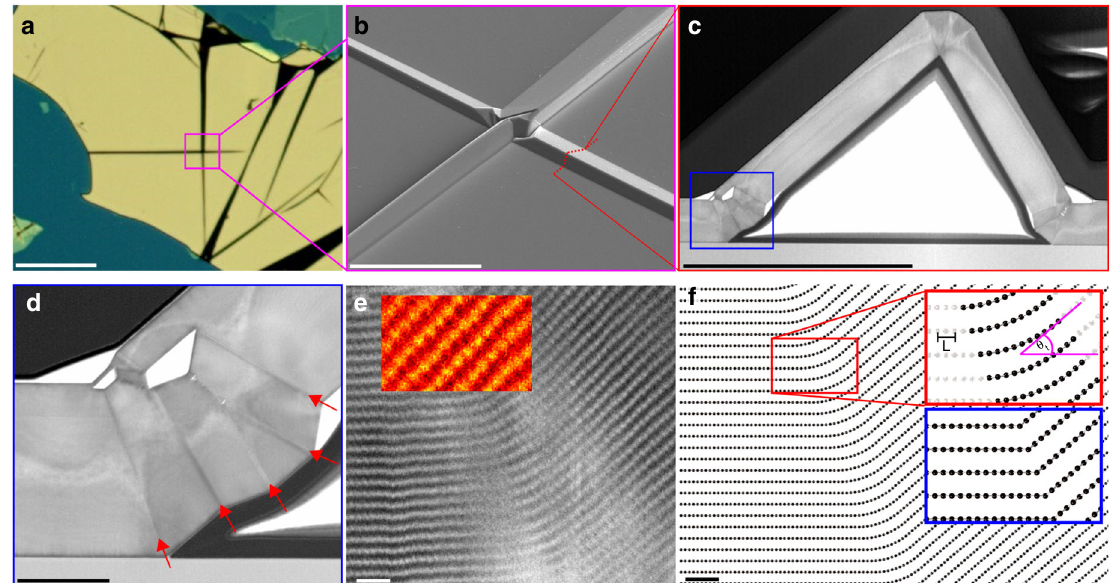
Fig. 1 Atomic structure of twin boundaries in layered vdW crystals, a Optical plan view image of a 200 nm thick graphite fl ake on silicon wafer. Stress induced kink bands can be seen intersecting one another at angular multiples of 30° (corresponding to zig-zag, zz, or armchair, ac, crystal directions). Scale bar 100 μ m. b Scanning electron microscopy (SEM) oblique view of zz kink band meeting an ac kink band at 90°. The site of the FIB cross-section is annotated red. Scale bar 10 μ m. c , d Bright fi eld STEM cross-sectional imaging of the ac kink band. The kink is composed of fl at areas of Bernal stacking bordered by many discrete boundaries of almost exactly the same angle, (boundaries annotated with red arrows) which are identi fi ed as incommensurate twin boundaries (see SI). Scale bars 1 μ m and 100 nm, respectively. e Filtered atomic resolution image of a twin boundary in hBN. The inset shows perfect atomic AA ’ stacking is maintained either side (parent and twin lattices) of the twin boundary. The core of the boundary is composed of a volume of crystal, which bends like a nanotube and is incommensurately stacked. Scale bar 1 nm. f Atomic model schematic comparing the delocalised incommensurate twin boundary structure (main fi gure and upper panel inset) with the conventional abrupt twin boundary (lower panel inset). The parameters that govern twin geometry, slip length L and the ideal twin angle θ t are annotated (Table 1). Scale bar 1